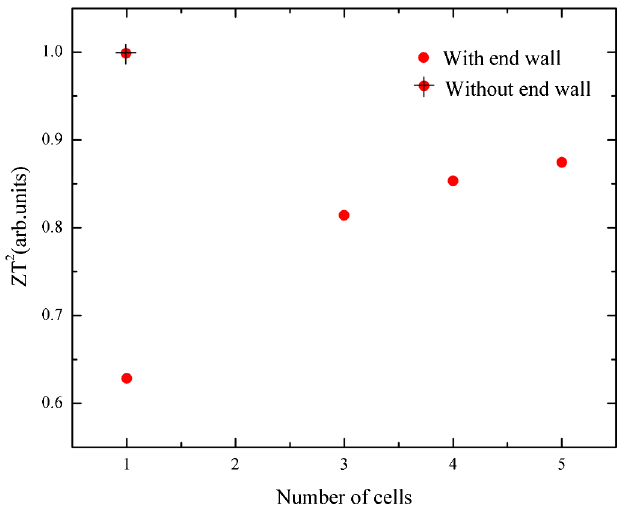
FIG. 2. The dependence of the shunt impedance from the number of cells for an SDTL for (cid:2) ¼ 0 : 3 at 325 MHz.